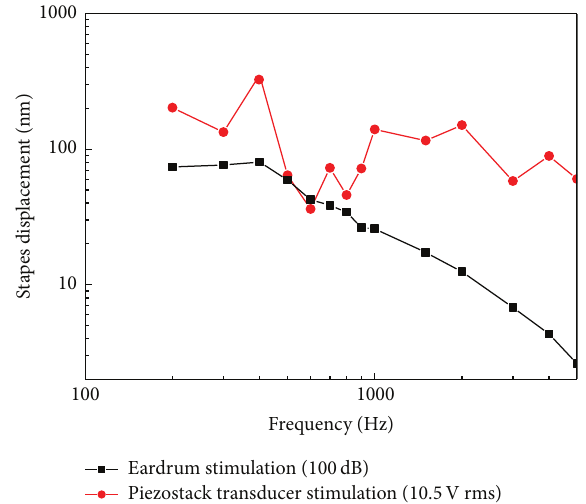
Figure12:Stapes displacements drivenby thepiezostack transducer and the acoustic stimulations at the eardrum.